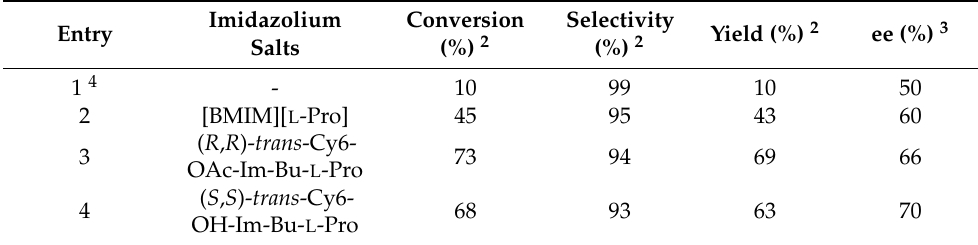
Table 2. Results for the aldol reaction between p -nitrobenzaldehyde and acetone with different imidazolium L -prolinates (40% catalyst loading) at room temperature in DMSO-d6 1 .